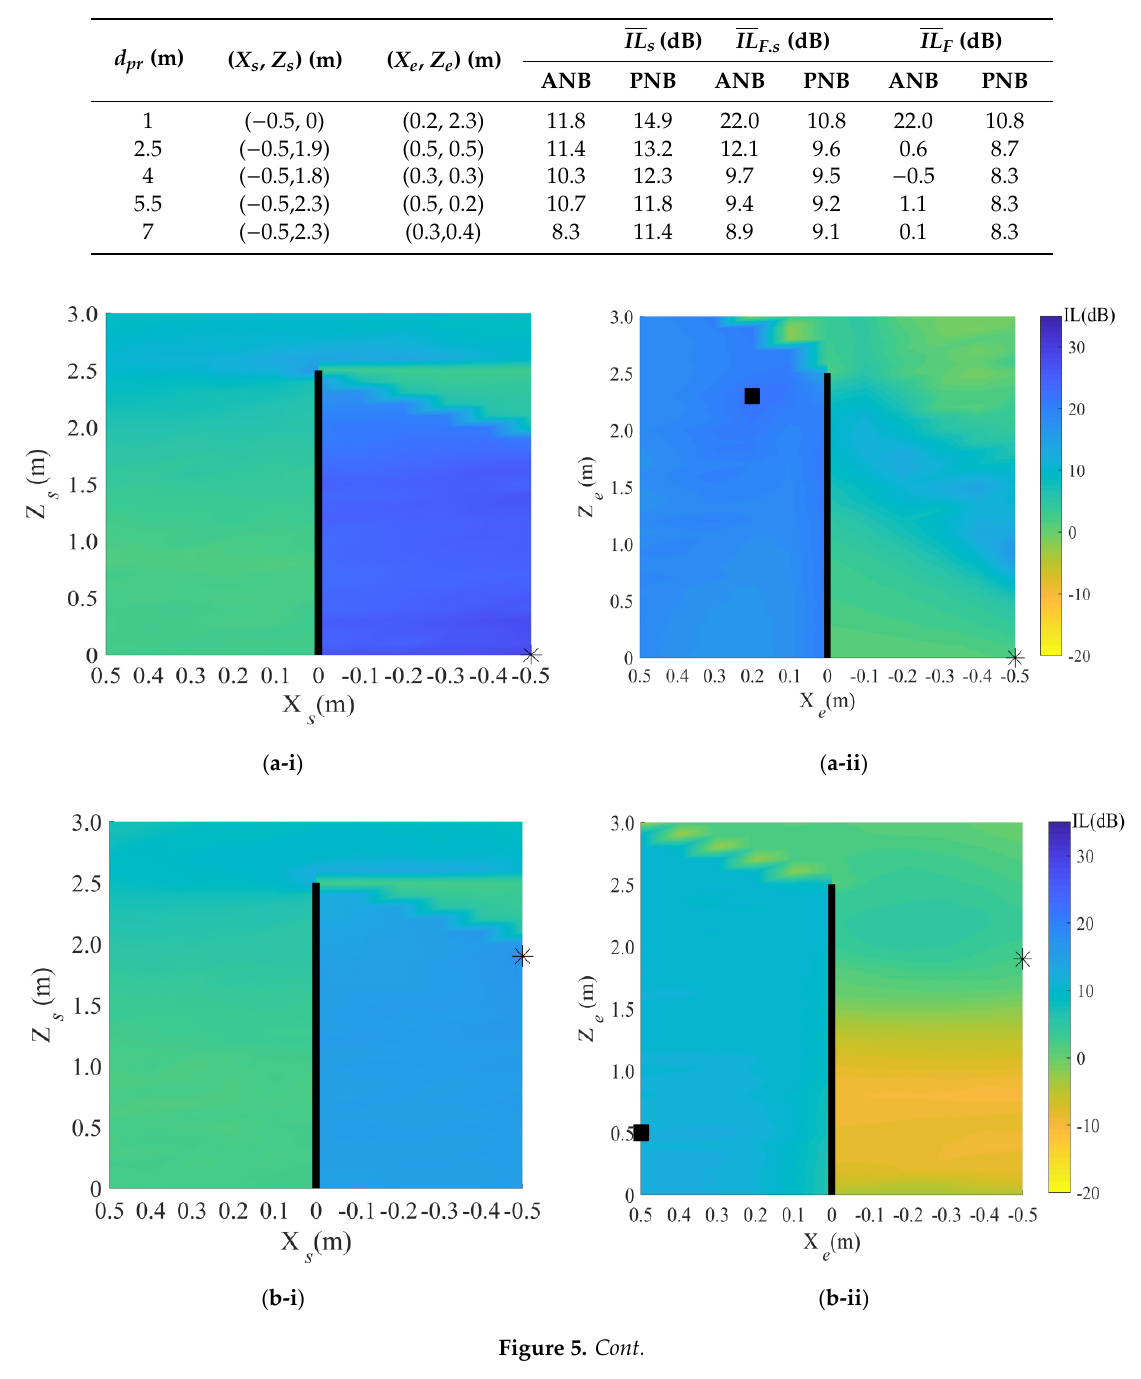
Table 2. The best positions of the secondary sources and error microphones in the control zone, when the target zone is the shadow zone of the façade. Variables are similar to Table 1.